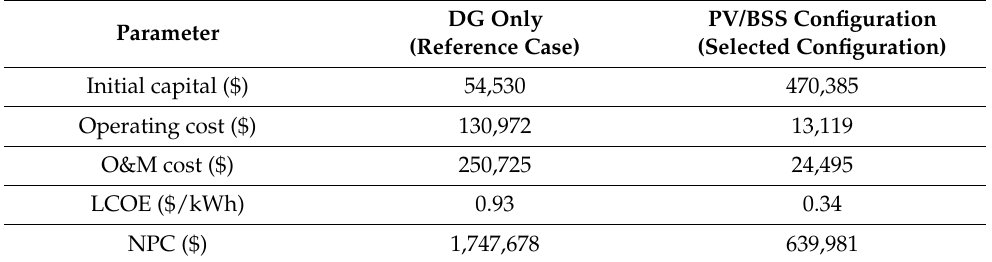
Table 12. Comparison between the selected configurations of HPGP with the reference case.